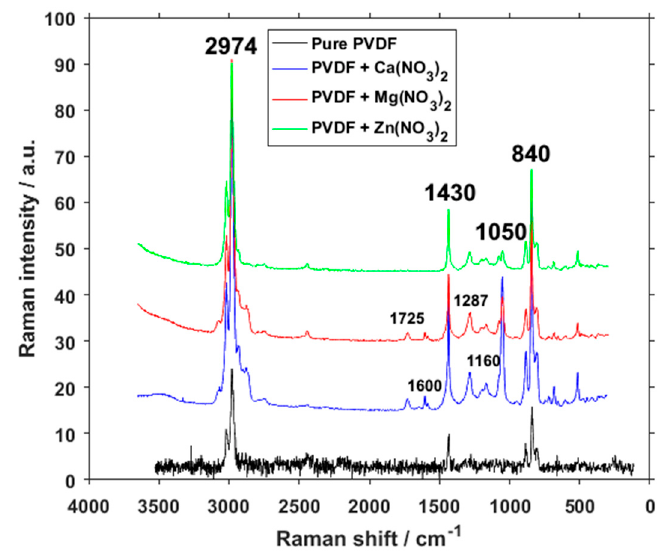
Figure 6. Raman spectra of pure PVDF fibers and PVDF fibers with Ca(NO 3 ) 2 , Mg(NO 3 ) 2 and Zn(NO 3 ) 2 .